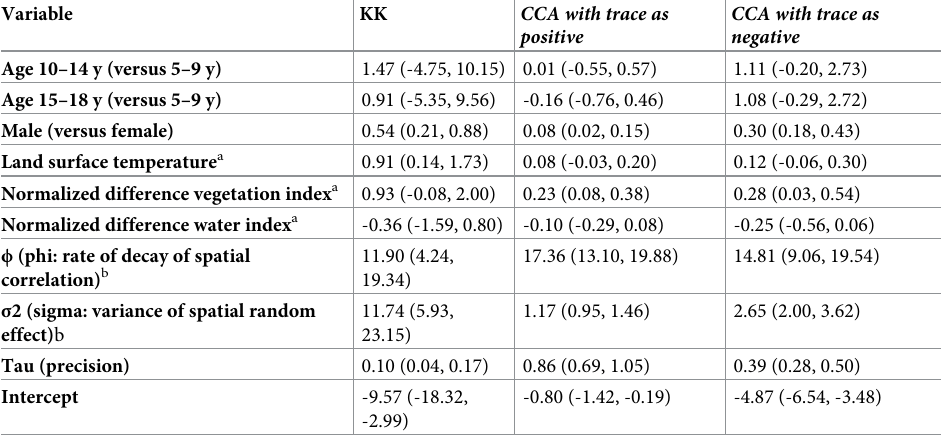
a Variables were standardized to have mean = 0 and standard deviation = 1